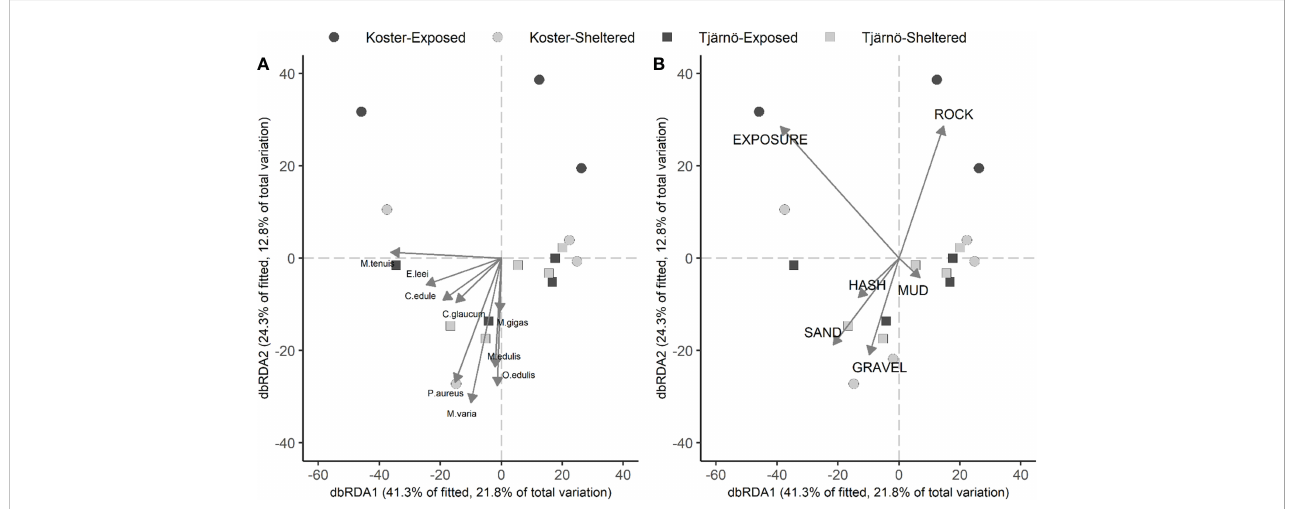
FIGURE 3 Ordination plots of distance-based redundancy analysis (dbRDA) correlation vectors for (A) species (excluding those occurring at<4 sites and with correlations<0.3, epifaunal indicated represented by bold letters) and (B) environmental variables. Distances are based on Bray-Curtis of 4 th root transformed